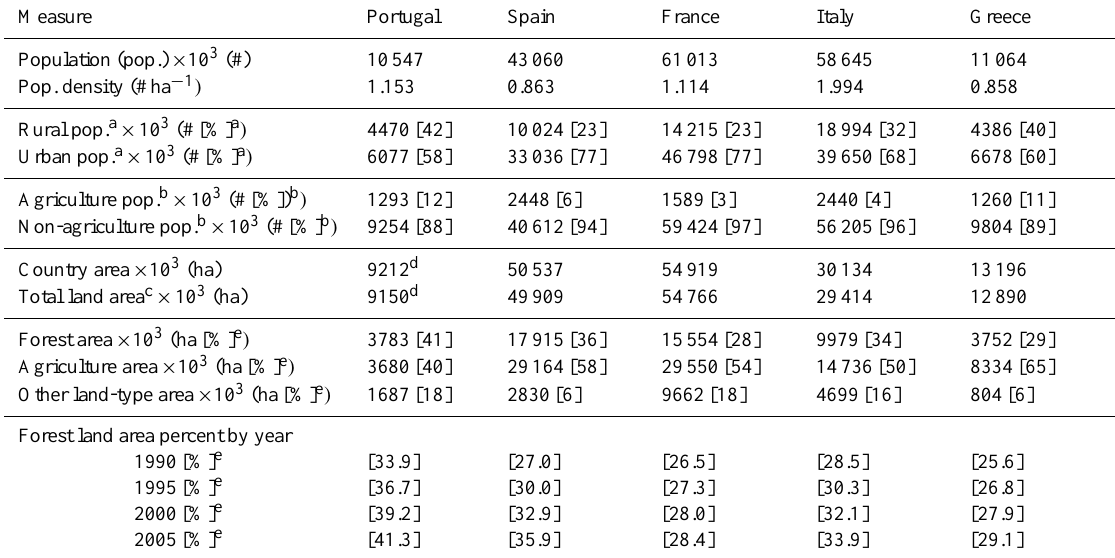
Table 2. Population and land area statistics for five northern Mediterranean countries for the year of 2005 and percent of land area which was forested for 1990, 1995, 2000, and 2005. All data from FAOSTAT (2011).